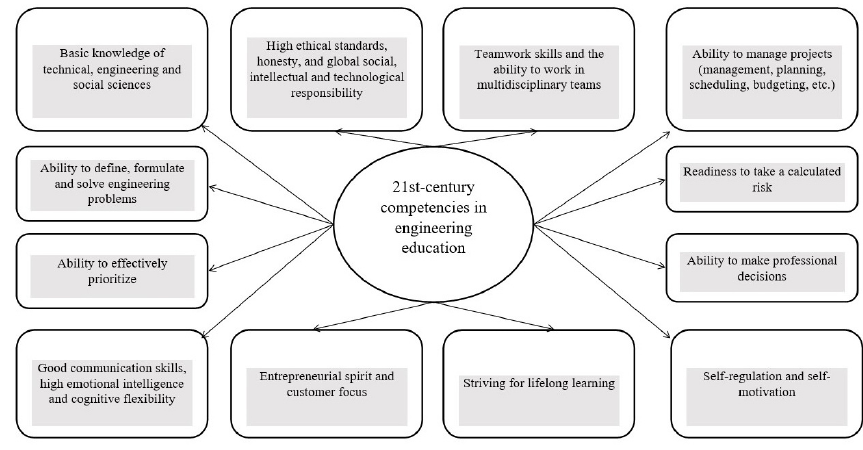
Fig. 1. Competencies of a 21st-century engineer